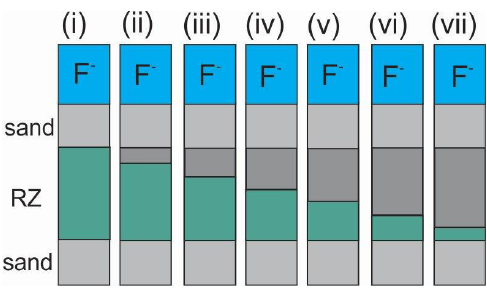
Water 2015 , 7 type, sand grading/sorting) can also be investigated.